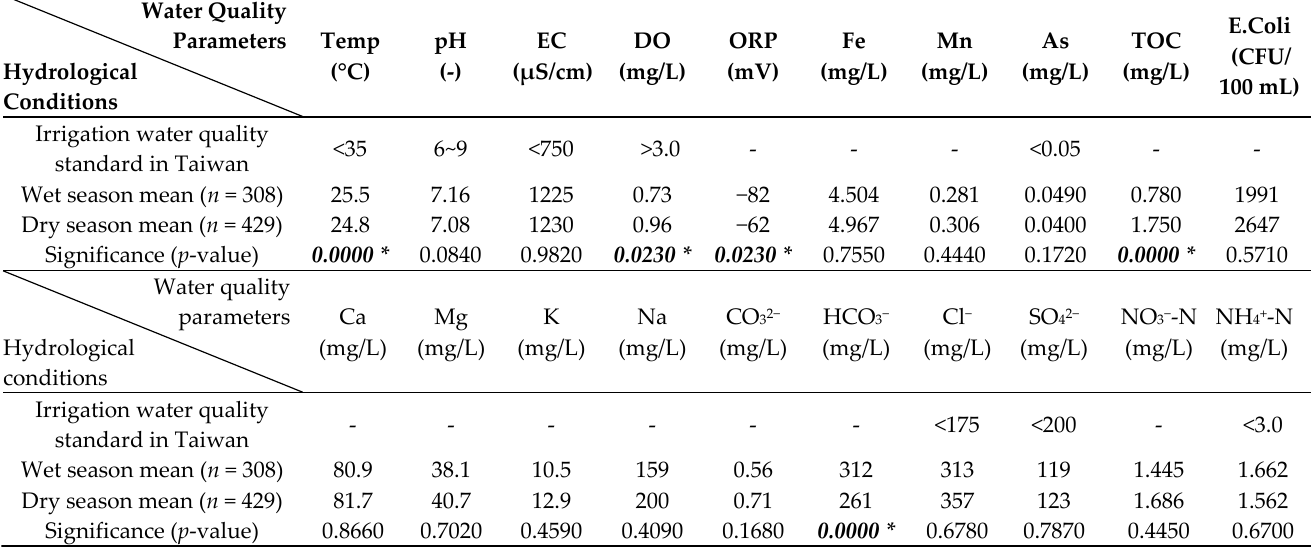
Table 3. Independent samples t -test of groundwater quality parameters in the Zhuoshui River alluvial fan Aquifer 1 and Aquifer 2 between the wet and dry seasons from 2008 to 2020.